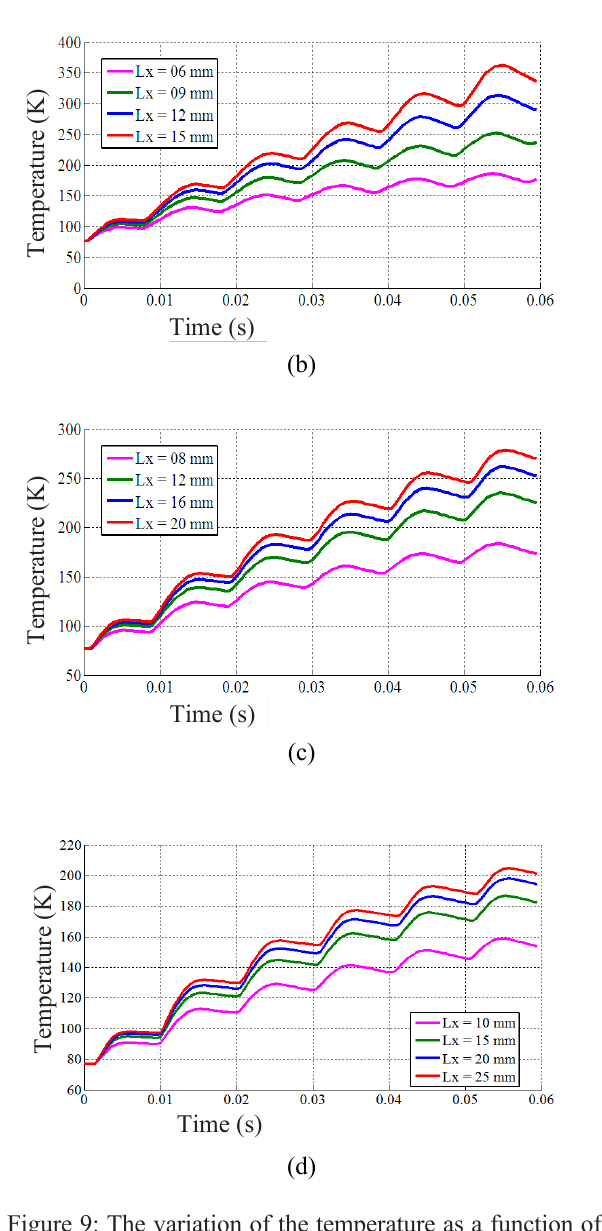
Figure 9: The variation of the temperature as a function of time for variable Lx. in the different pellets respectively (a), pellet A , (b) pellet B , (c) pellet C and (d) pellet D .